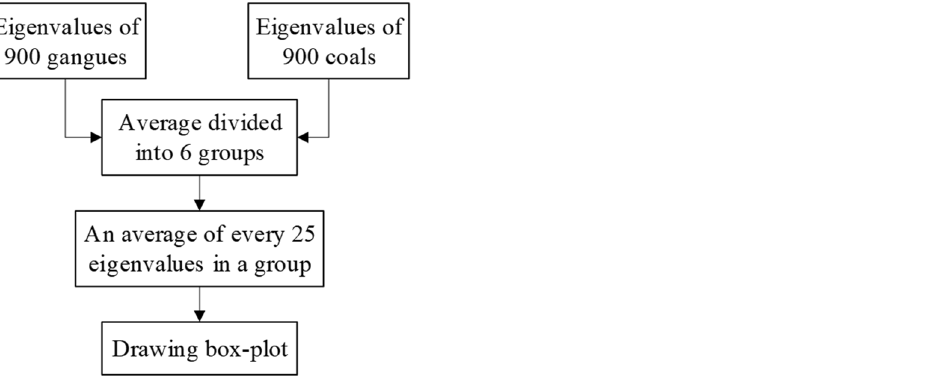
Experiment on extracting gray and texture eigenvalues of coal and gangue images